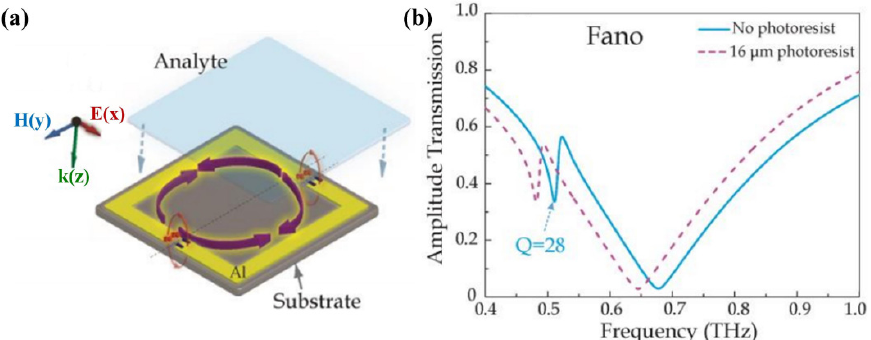
Figure 4. ( a ) Diagram of asymmetric resonant ring with analyte. Adapted with permission from Ref. [73]. Copyright (2014), AIP Publishing LLC. ( b ) The transmission of Fano resonance with different analytes.